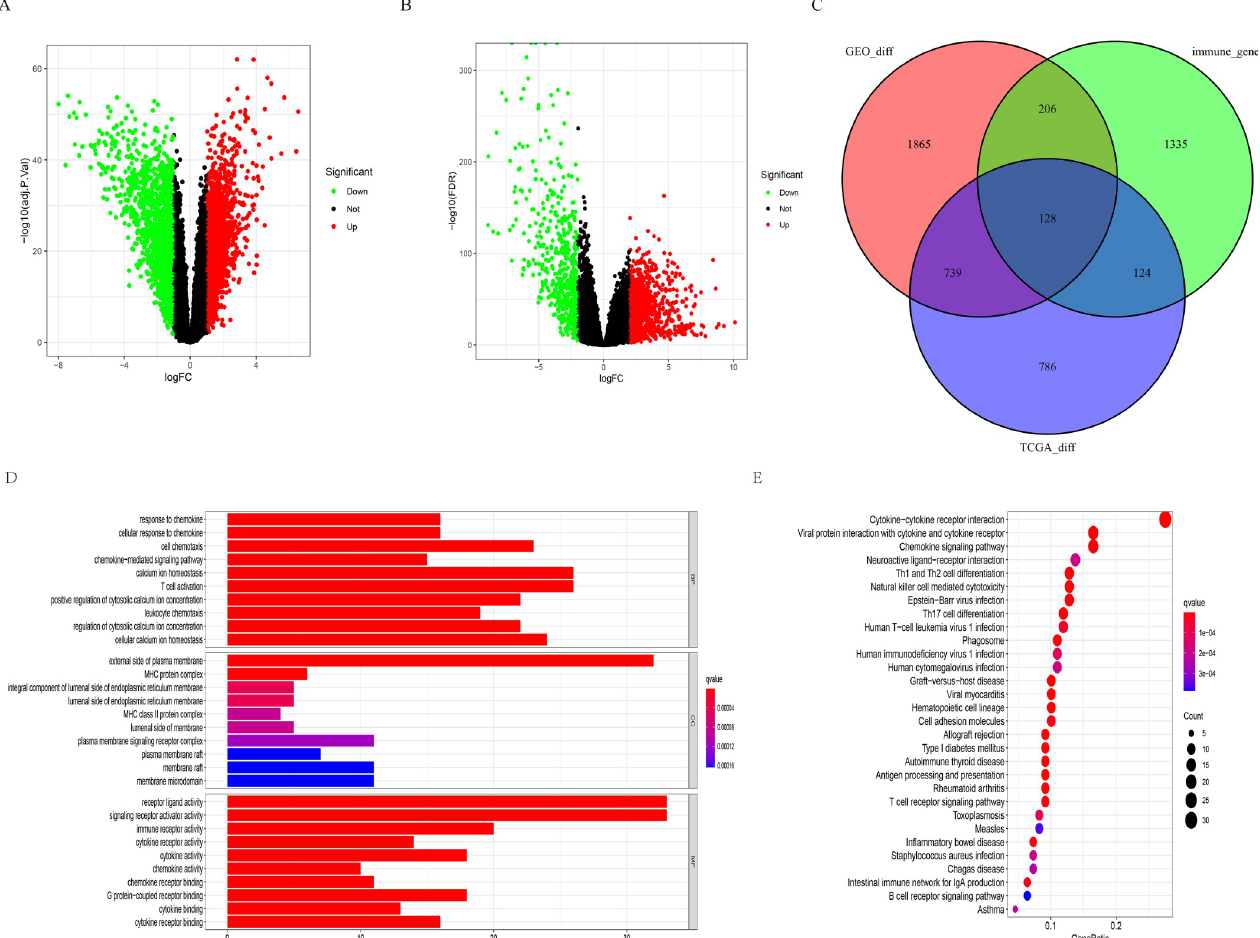
Fig 1. Differentially expressed IRGs. (A-B) represents the volcano map of DEGs from the TCGA and GSE53757 datasets. (C) Venn diagrams of DEGs in TCGA and GSE537357 dataset and IRGs. (D-E) GO and KEGG enrichment analysis of differential expression of IRGs. BP, biological process. CC, cellular component; MF, molecular